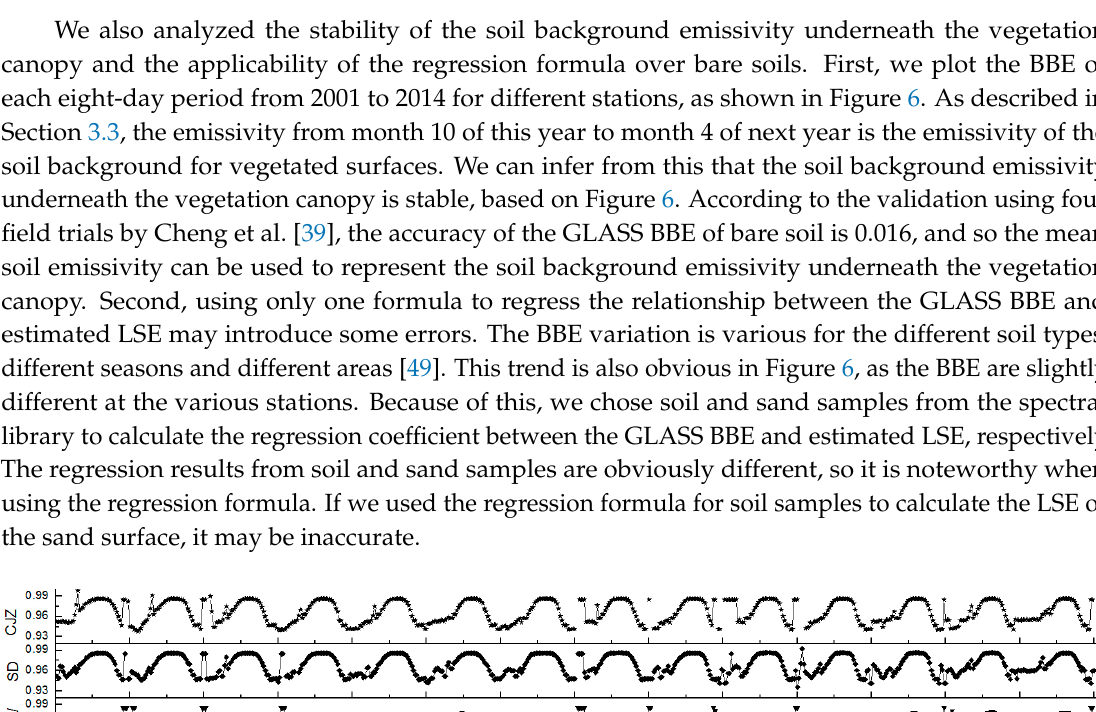
Figure 5. LSE simulated by 4SAIL model varying LAI at a fixed soil emissivity of 0.96 (left) or a fixed leaf emissivity of 0.96 (right).